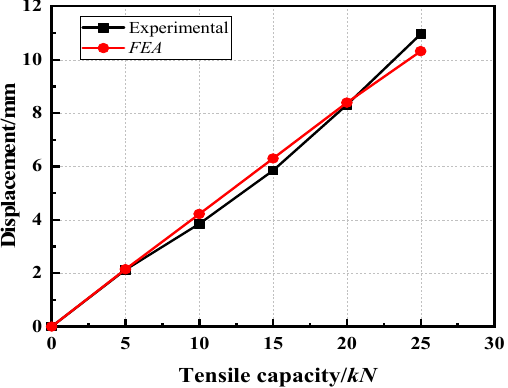
Figure 7. Eccentric tensile capacity of sockets on horizontal